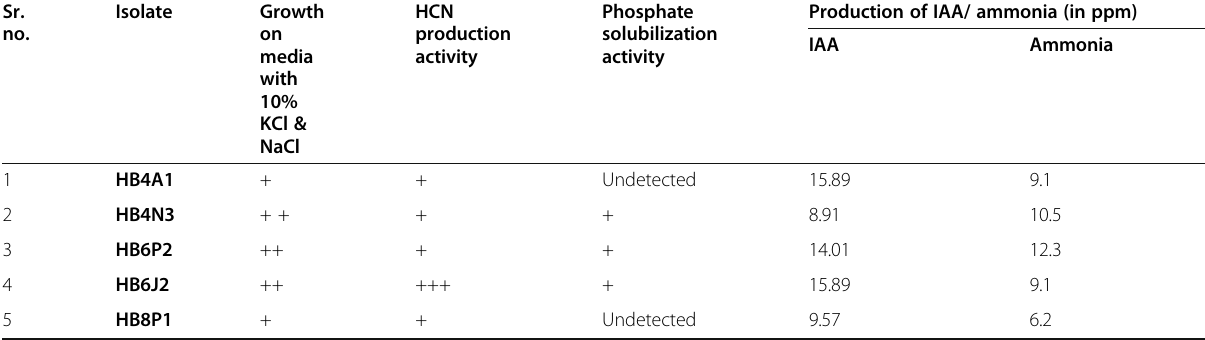
Table 4 Plant growth promoting (PGPR) activities of salt tolerant bacterial isolates Sr.